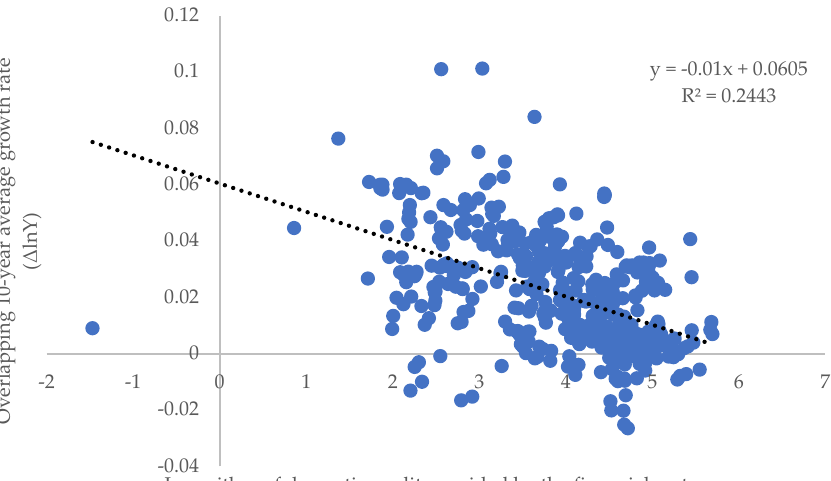
Figure 2. Relationships between financialisation and long-run economic growth in 1996–2017. Source: all calculations are based on data from The World Bank’s World Development Indicator’s and Governance Indicator’s databases.